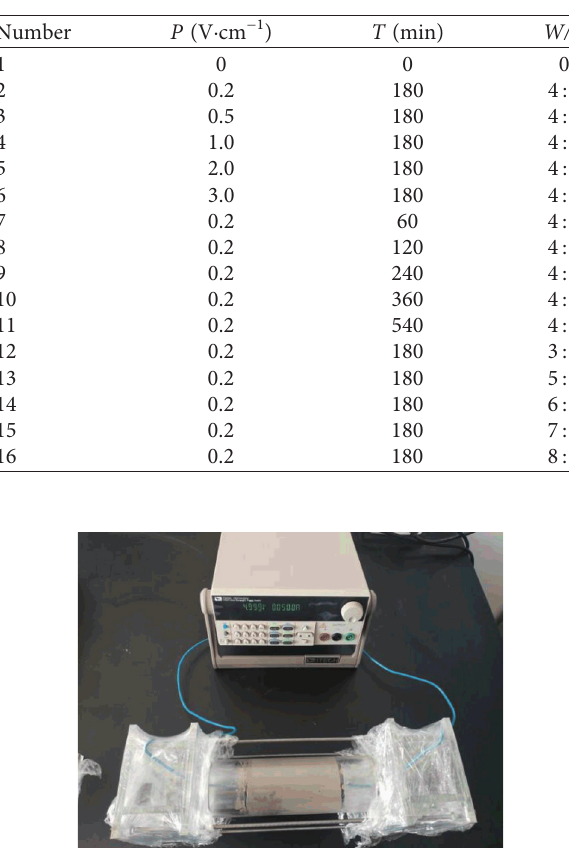
Table 2: Experiment scheme of electrochemical modification on the HWBM.